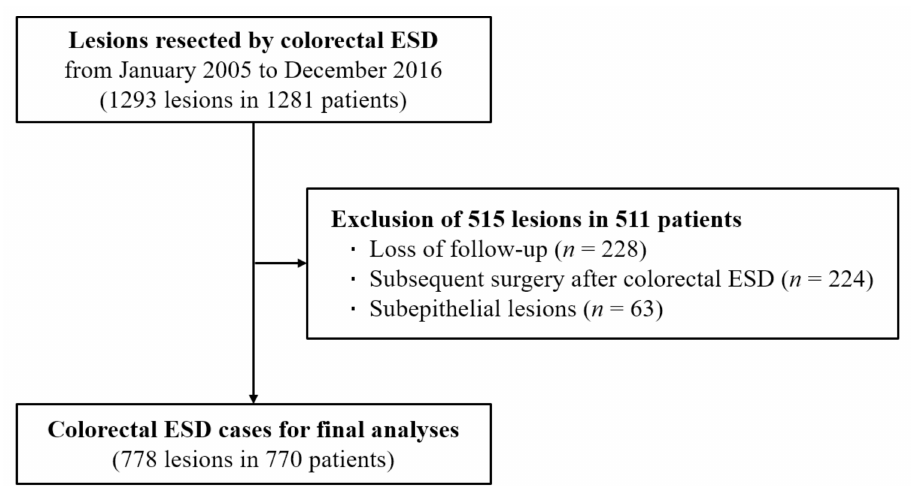
Figure 1. Flow chart for inclusion of